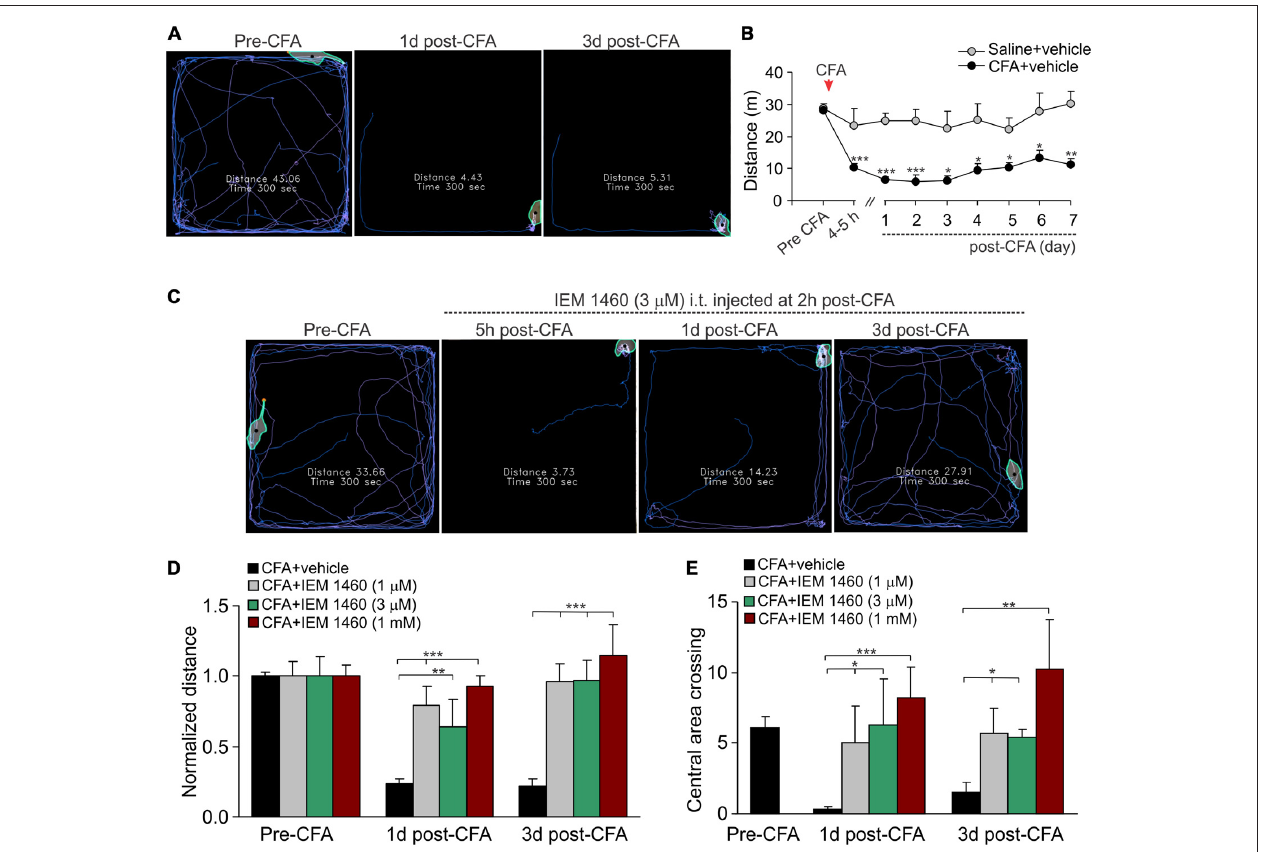
FIGURE 3 | The IEM-1460-induced relief in locomotive deficit and the anxiety-like behavior of inflamed animals. (A) The open-field test snapshots demonstrate the severe locomotive deficit in rats with developed peripheral pain syndrome. Sketches of the animal movements taken from the same animal before and at different time-points after induction of inflammation indicating the total distance traveled by an animal for 5 min of recording. (B) Summary of the total distance traveled (a 5 min duration) by the saline-treated and the CFA-inflamed animals over the time. Data are expressed as mean ± SEM. ∗ p < 0.05, ∗∗ p < 0.01, ∗∗∗ p < 0.001 vs. the correspondent time-point in saline. One-way ANOVA and Bonferroni post hoc test. (C–E) Treatment with IEM-1460 recovered the inflammatory-induced locomotive deficit (D) and the anxiety-like behavior (E) as seen from the representing open-filed recordings taken from the same animal before and after the induction of peripheral inflammation followed by IEM-1460 treatment (C) . ∗ p < 0.05, ∗∗ p < 0.01, ∗∗∗ p < 0.001 vs. the indicated bar. One-way ANOVA and Bonferroni post hoc